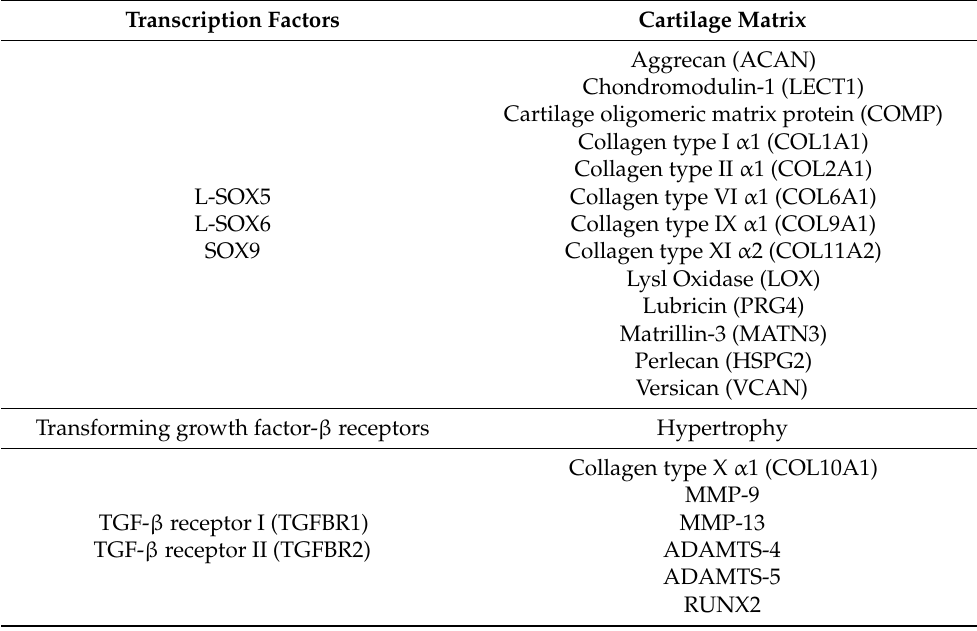
Table 1. List of chondrogenic genes used in custom PCR